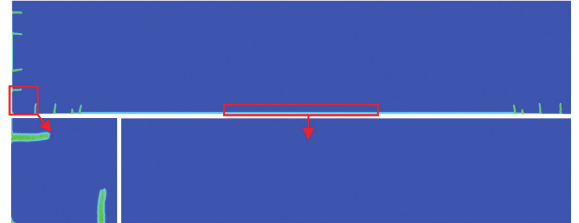
Figure 6: Surface damage on slab skin (result of the modified PD model in present work, t �